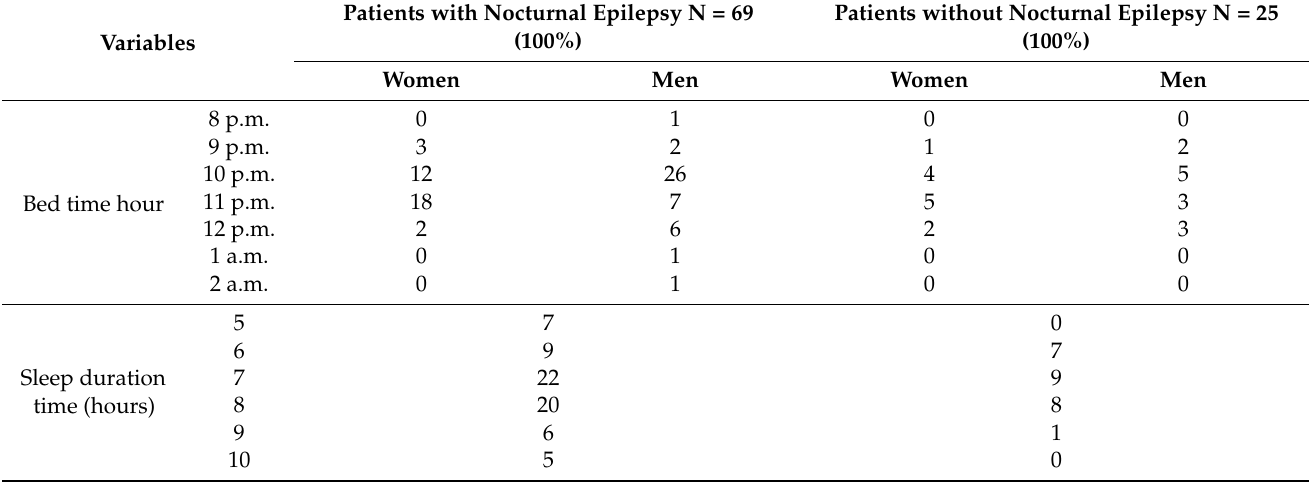
Table 3. Bedtime hour and sleep duration